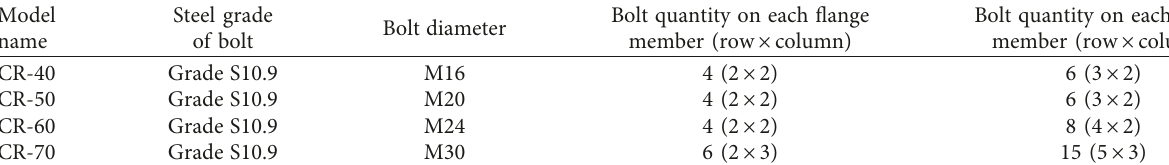
Table 2: Details of connection.